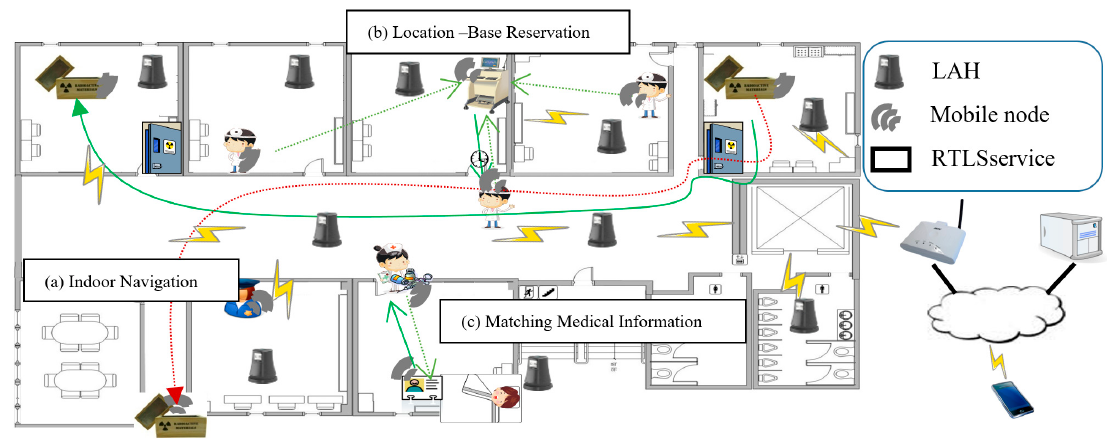
Figure 1. Location Anchor Hub (LAH) based real-time location system (RTLS) in a hospital.